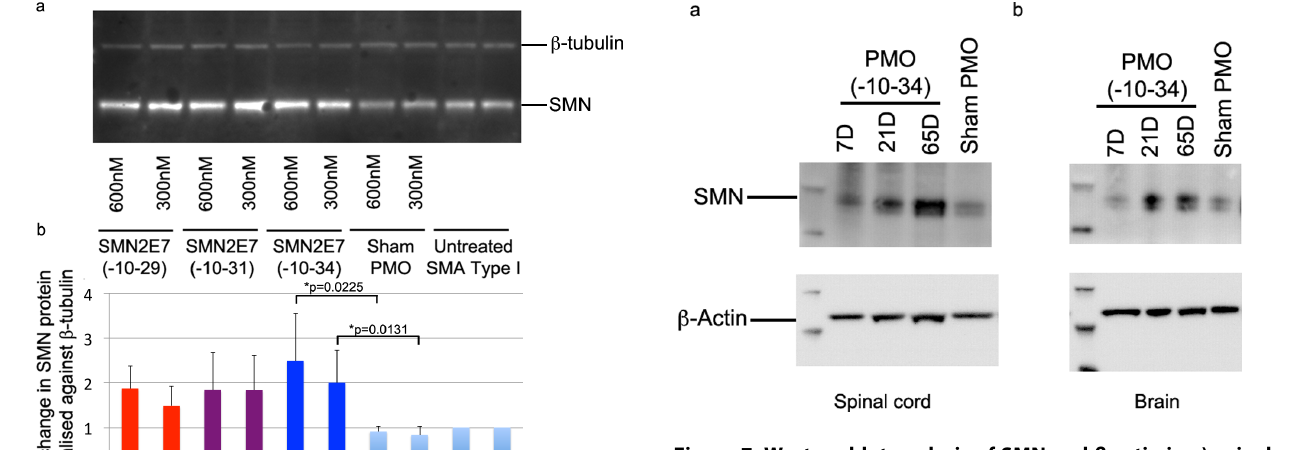
Figure 7. Western blot analysis of SMN and ß-actin in a) spinal cord and b) brain of SMA carrier mice (Smn + / 2 ; SMN2 + / + ; D 7 + / + ) intracerebroventricularly injected with 6 mM of PMO(-10-34) or scrambled PMO control. Tissues were collected at 7, 21 and 65 days after PMO(-10-34) injection and at 21 days after scramble PMO